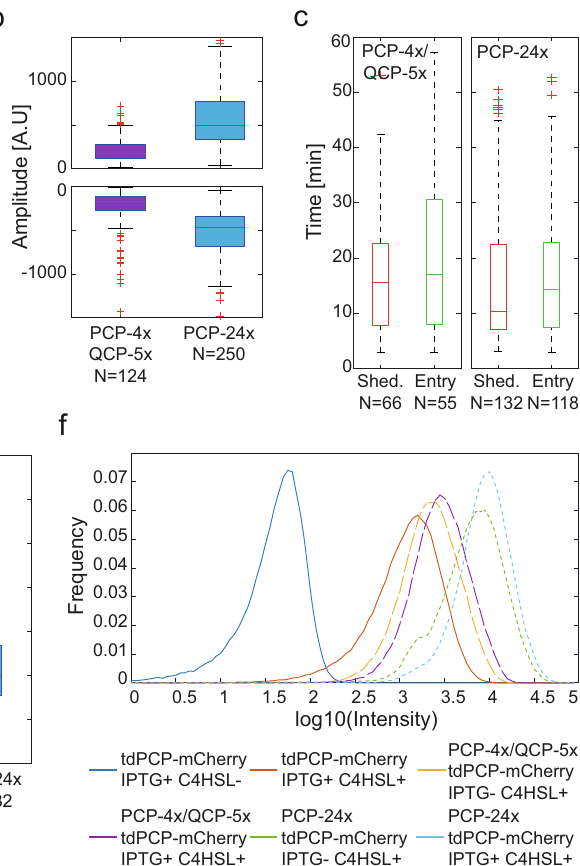
each box, the central mark indicates the median, and the bottom and top edges of theboxindicatethe25thand75thpercentiles,respectively.Thevaluefor ‘ Whisker ’ corresponds to ±1.5IQR (interquartile rate) and extends to the adjacent value, whichisthe mostextremedatavalue thatisnotanoutlier.Theoutliersare plotted individually as plus signs. f Population intensities of E. coli BL21 cells expressing tdPCP-mCherrywithdifferentslncRNAsanddifferentcombinationsofinductionas measured by fl ow cytometry. Source data are provided as a Source data fi